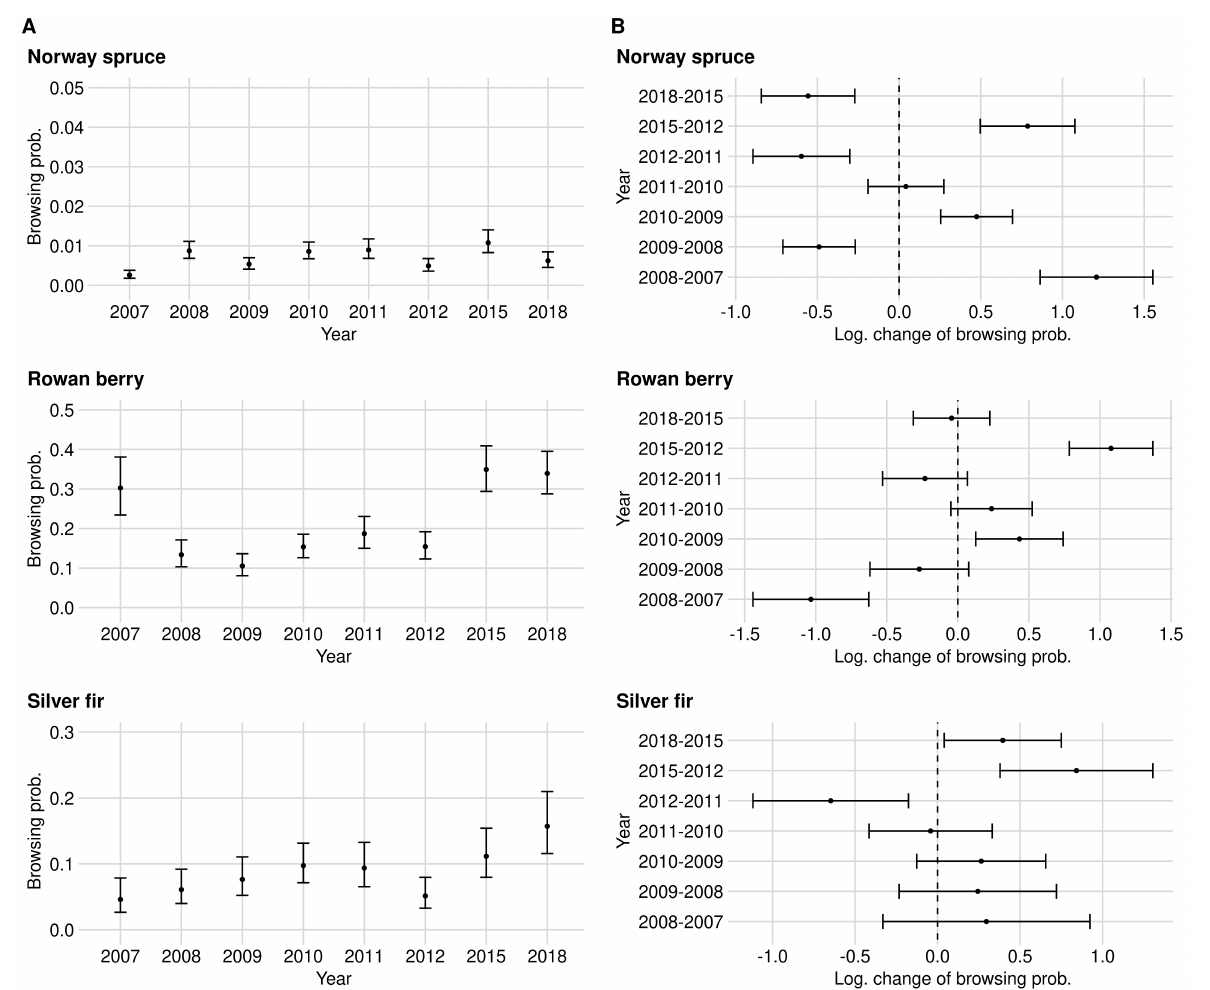
Figure 2. Time series and confidence intervals of the BP ( A ) and the corresponding logarithmic change of the BP between two consecutive acquisition years ( B ). The estimated logarithmic change of BP (black point inside the confidence intervals) is positive if BP increased compared to the previous year and the change is negative if it decreased. If either the upper or the lower end of the confidence intervals completely crossed the zero on the x-axis, the change of the BP is not significant. The estimates are related to the data set of the entire